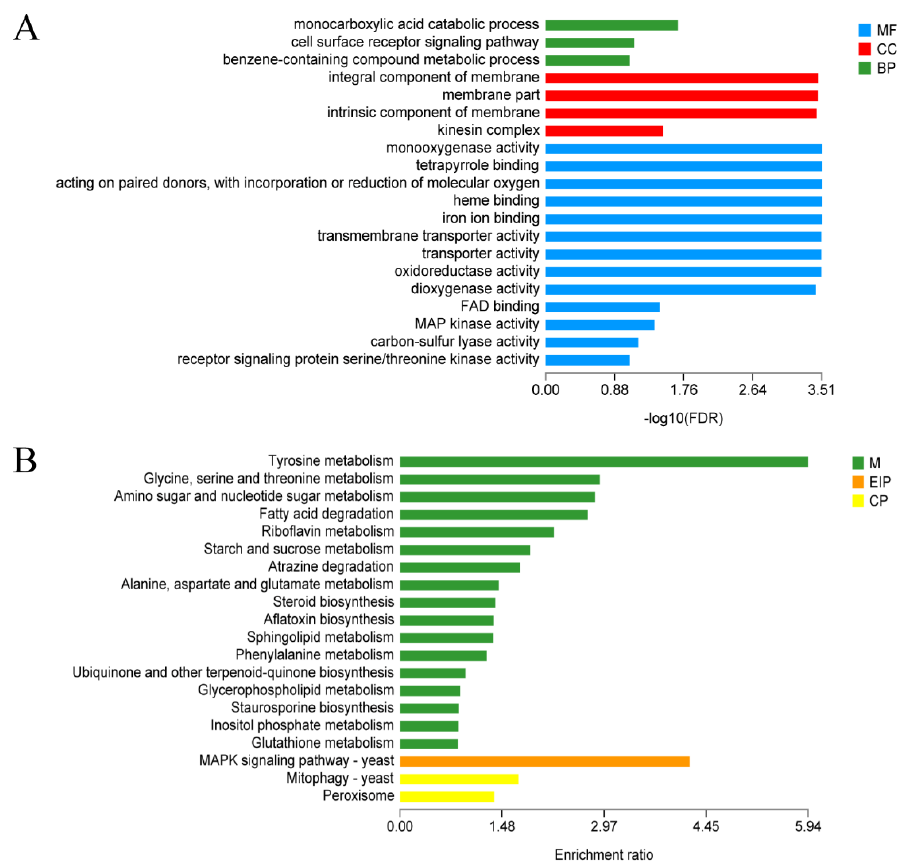
Figure 6. Functional annotation of DEGS in A. sinodeliciosus var. Chaidam ZJU-TP-08 under blue light (B), yellow light (Y), yellow–blue shift (YB) light stimulation. ( A ) GO annotation analysis of DEGs from Ca-D vs. Ca-Y, Ca-D vs. Ca-B and Ca-D vs. Ca-YB group. The vertical axis represents GO term, the horizontal axis represents the significance level of enrichment, and the three colors represent three categories, namely biological process (BP), cell component (CC), and molecular function (MF). ( B ) The top 20 KEGG annotation pathways from Ca-D vs. Ca-Y, Ca-D vs. Ca-B, and Ca-D vs. Ca-YB group. The vertical axis represents the KEGG pathway, and the abscess axis represents the significant level of enrichment. Different colors represent three branches of the KEGG metabolic pathway, namely cell metabolism (M), environmental information processing (EIP), and cellular process (CP).